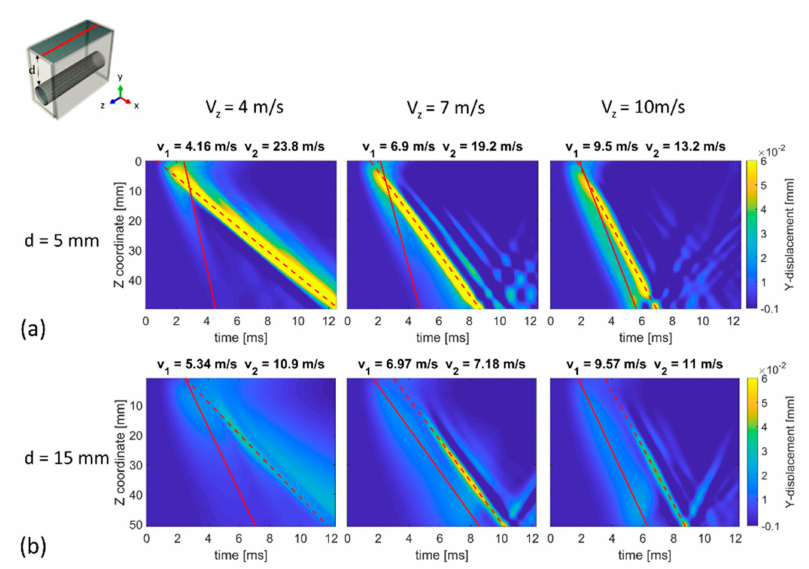
Figure 7. TOF plot at the skin surface for the CCA with depth d of ( a ) 5 mm and ( b ) 15 mm when imposing a traveling pulse (V z of 4, 7 and 10 m / s). The propagation velocities of the main (V 1 ) and secondary (V 2 ) wave front are marked by slope of the dashed and solid lines, respectively.